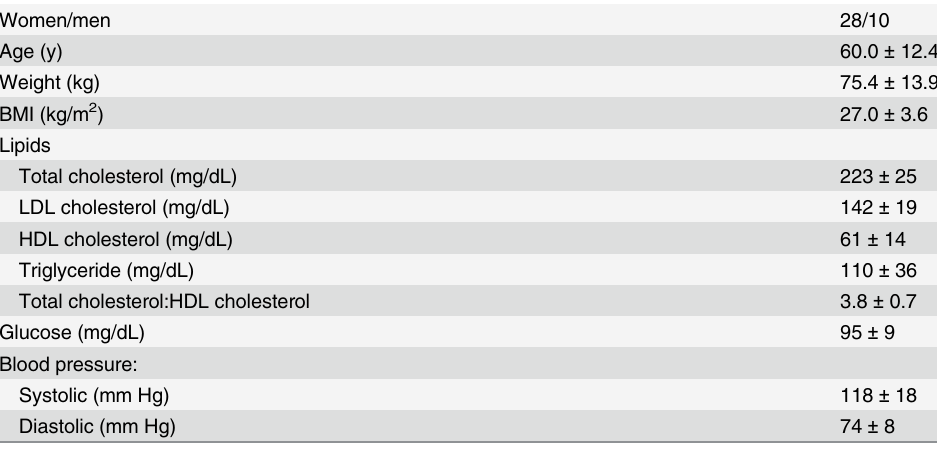
Table 1. Participant characteristics at